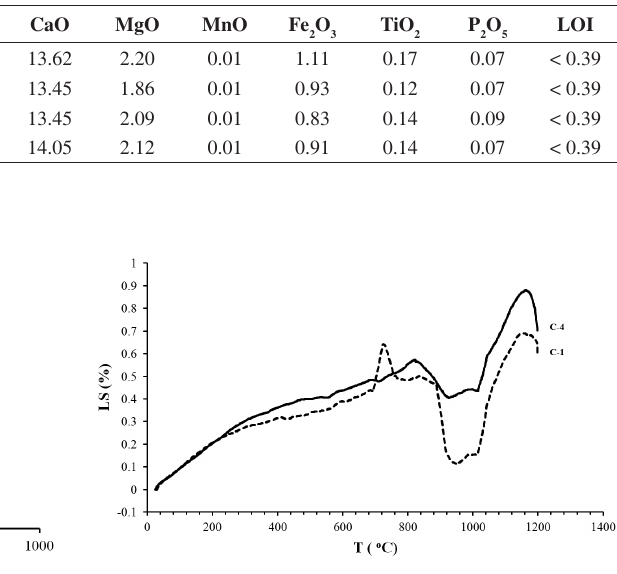
Figure 2. Shrinkage-temperature plots of compositions C-2 and